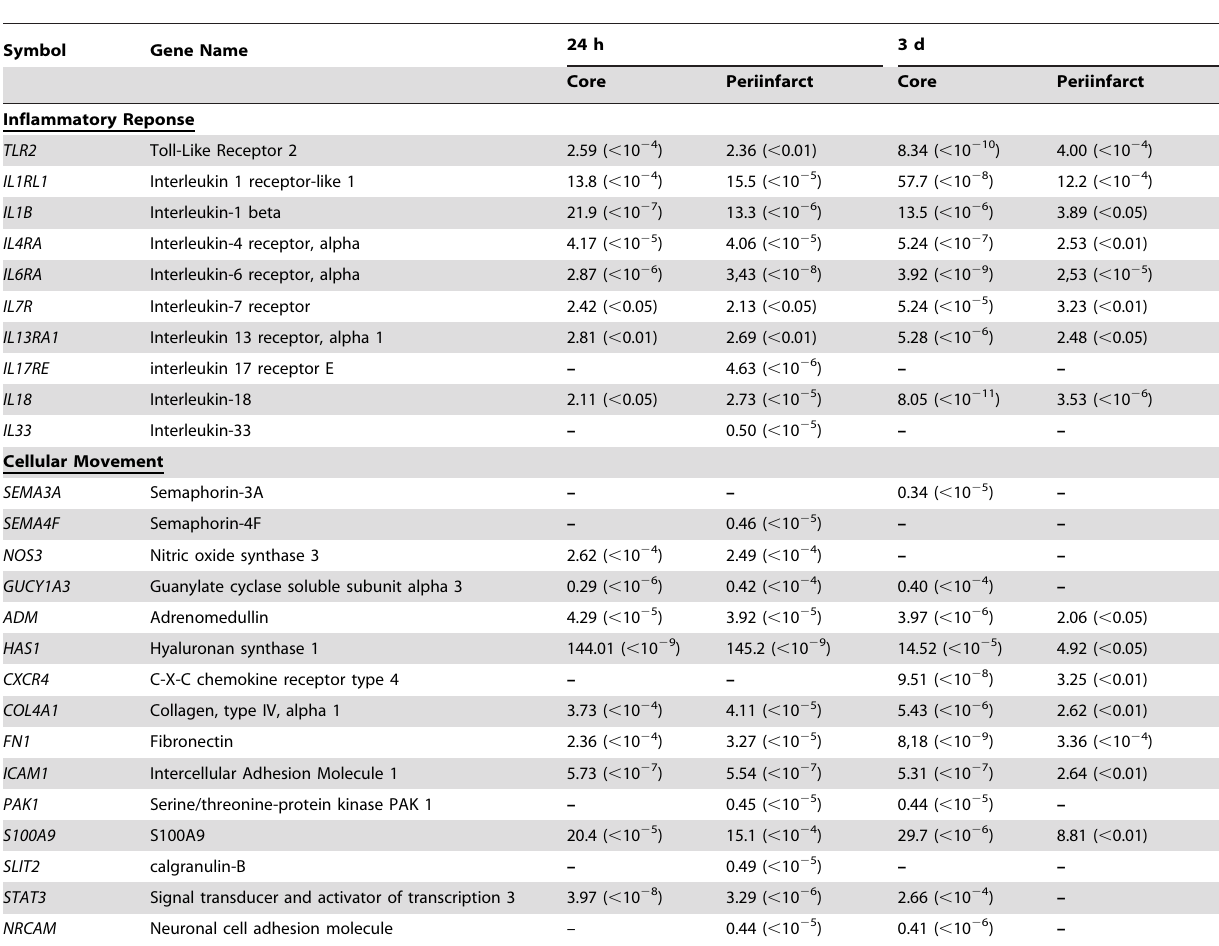
Table 2. Regulation of inflammatory response and cell movement-associated genes in the core and perriinfarct after permanent focal cerebral